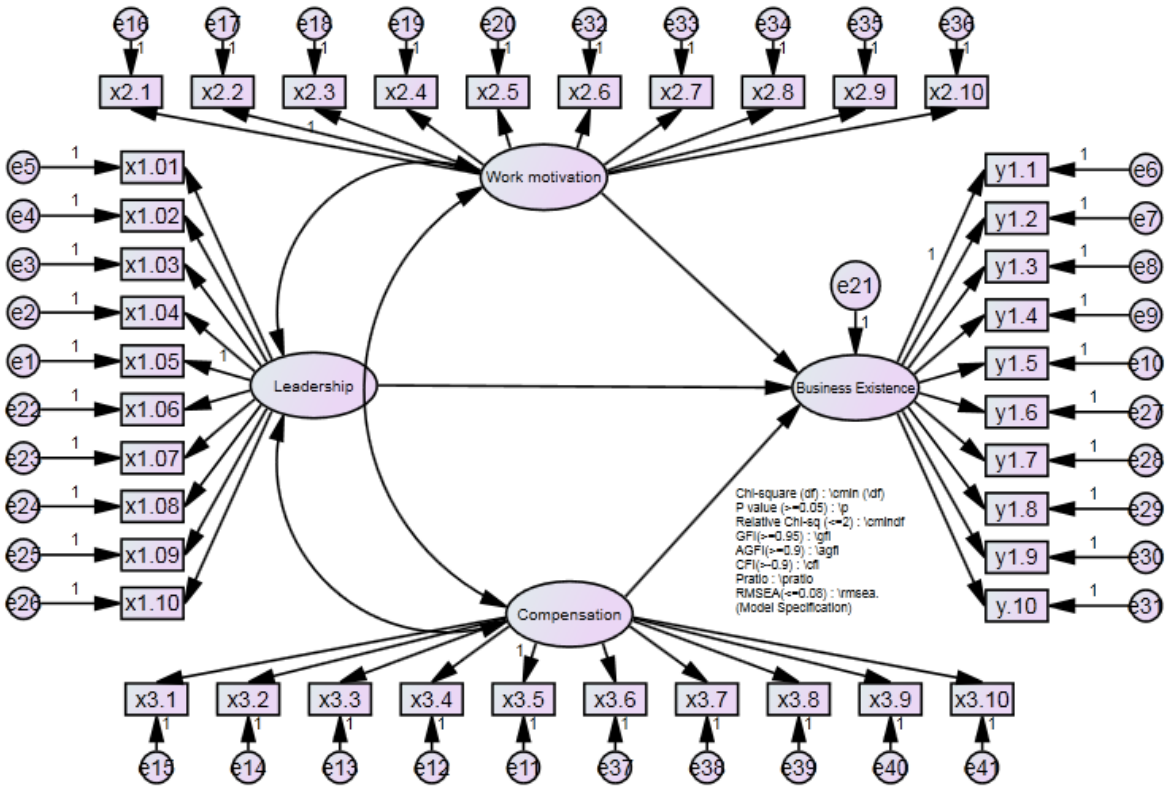
Figure 5. Full Model